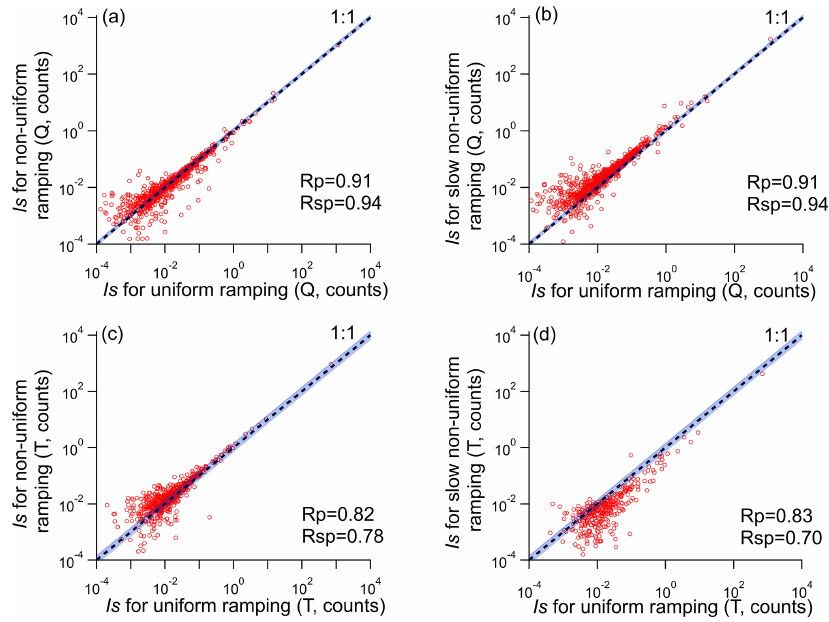
Figure 5. Comparison of Is from the different temperature ramping protocols of the 24h quartz (Q) and Teflon (T) filter samples, (a) non- uniform and uniform ramping (quartz sample), (b) slow non-uniform and uniform ramping (quartz sample), (c) non-uniform and uniform ramping (Teflon sample), and (d) slow non-uniform and uniform ramping (Teflon sample). The blue shaded areas represent the relative error in the signal assessed in the reproducibility tests of the 24h samples (18% for Teflon and 9% for quartz filters). The upper and lower limits for the reproducibility-based variation are calculated as (1 + 18%) / (1 − 18%) and (1 − 18%) / (1 + 18%), respectively. The upper and lower limits for the Is distribution of quartz caused by reproducibility are calculated as (1 + 9%) / (1 − 9%) and (1 − 9%) / (1 + 9%), respectively.